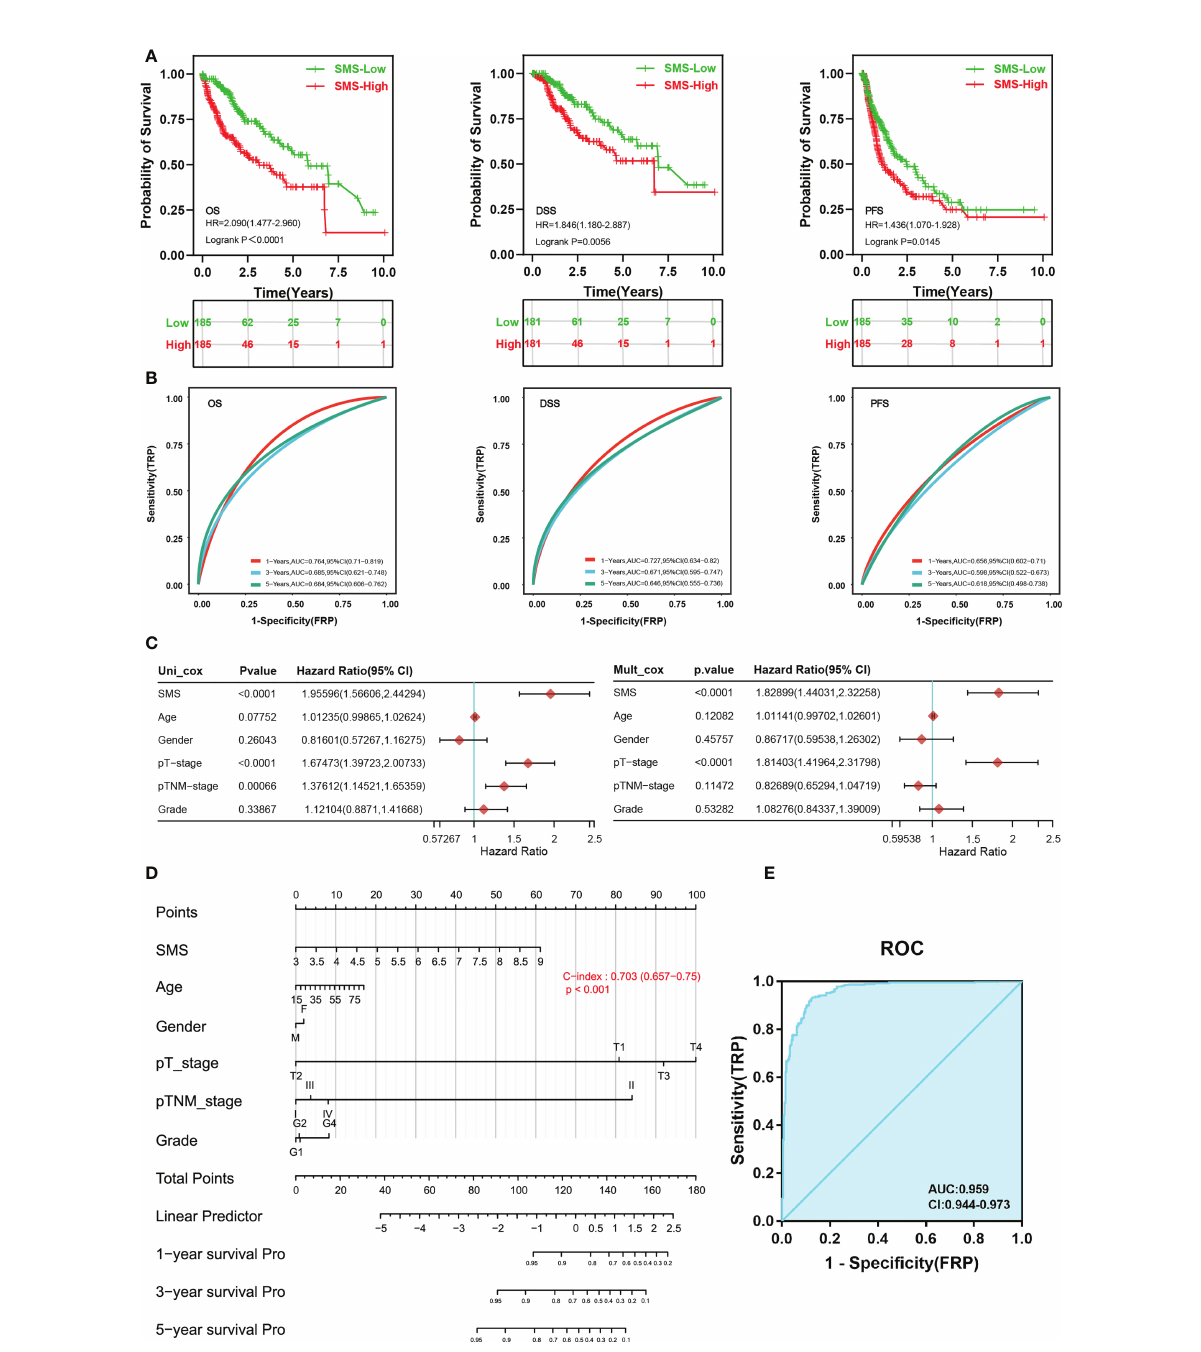
FIGURE 3 Differential SMS expression as a prospective biomarker of poor prognosis and to discriminate HCC samples. (A) OS, DSS and PFS of SMS mRNA in HCC cohort. (B) Time-dependent ROC analysis of SMS expression in HCC. (C) Forrest plot of univariate and multivariate Cox regression analysis in HCC. (D) Nomogram of SMS and other prognostic factors in HCC. (E) ROC curve assessing the performance of SMS for HCC